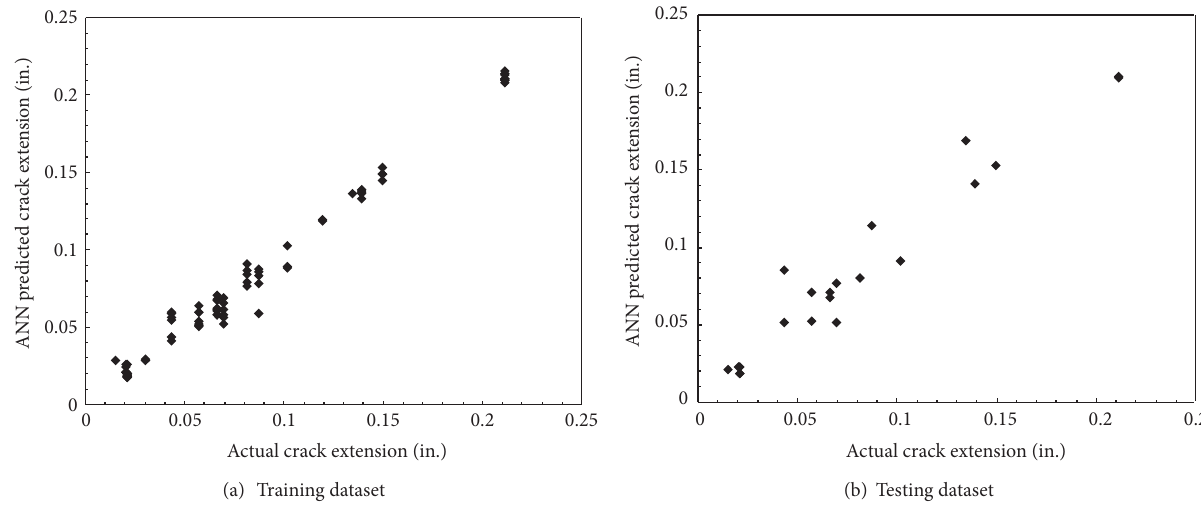
Figure 11: Results of training an artificial neural network to determine the magnitude of crack growth. These plots relate the target, or measured, size of crack growth in inches to the estimated ANN results. The correlation between the target values and ANN results was 0.9872 for the training dataset and 0.9453 for the testing dataset.